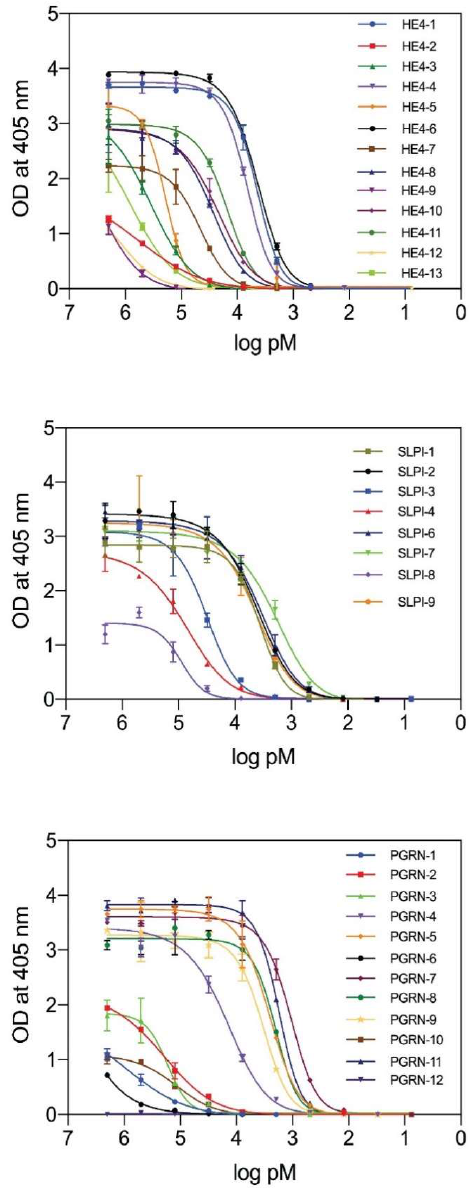
Figure 1. Indirect ELISA results showing the antigen-binding capacities of the nanobody variants targeting HE4 ( top ), SLPI ( middle ), and PGRN ( bottom ). To confirm the ELISA results and to obtain the kinetic rate constants of the Nb-anti- gen binding (k on and k off ), an antigen-binding study was performed using SPR. The kinetic association rate (k on , expressed in M −1 .s −1 ) and dissociation rate (k off , expressed in s −1 ) con- stants were determined, and the equilibrium dissociation constants (K D , expressed in nM) were calculated from the k off /k on ratios. The SPR sensorgrams of some representative Nbs are shown in Figure 2, and the binding parameters can be found in Table 2. An overview of all SPR sensorgrams can be found in Figures S1–S8, and the binding parameters are